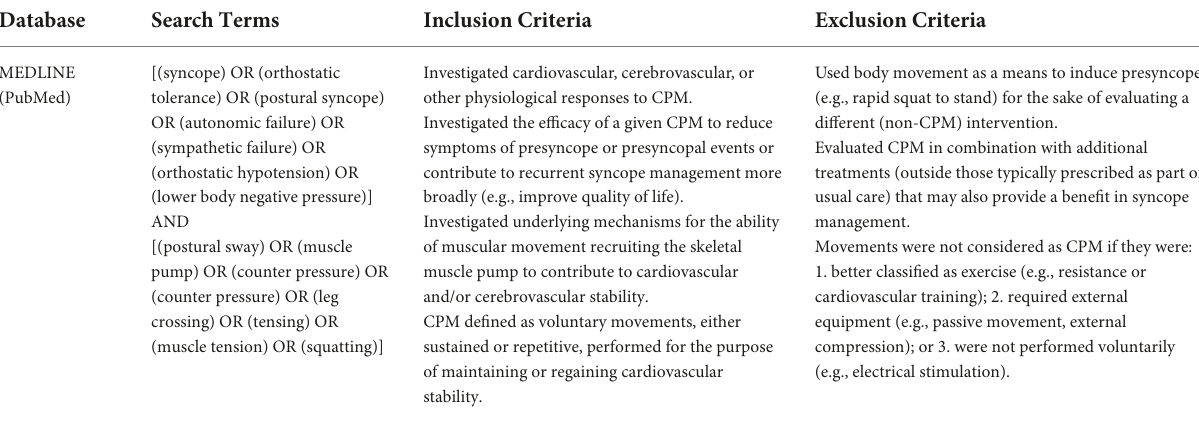
TABLE 1 Semi-systematic search